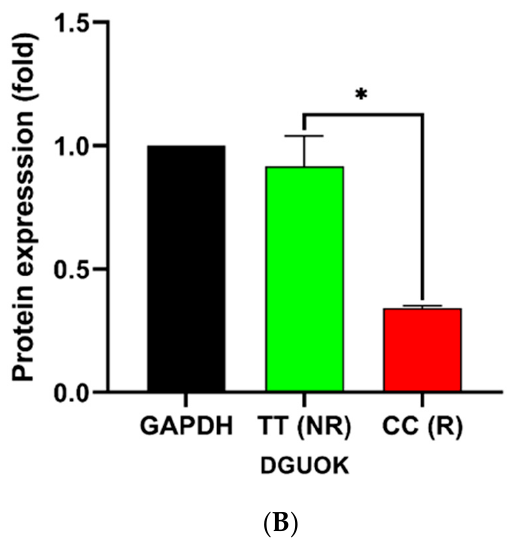
Figure 6. Western blot analysis of DGUOK protein in two risk (R1-GM18555, R2-GM18572) and two non-risk (NR1-GM18553, NR2-GM18561) genotype-specific LCLs (B-lymphoblastoid cells). DGUOK protein level was normalized to levels of glyceraldehyde 3-phosphate dehydrogenase (GAPDH). ( A ) Variation in DGUOK band intensity in genotype-specific LCLs. ( B ) Densitometry analysis showed that the normalized DGUOK expression was significantly reduced by ~3 fold in risk (R1 and R2; average R) compared to non-risk (NR1 and NR2; average NR) LCLs. P -value was determined by Student’s t-test. * p < 0.05.